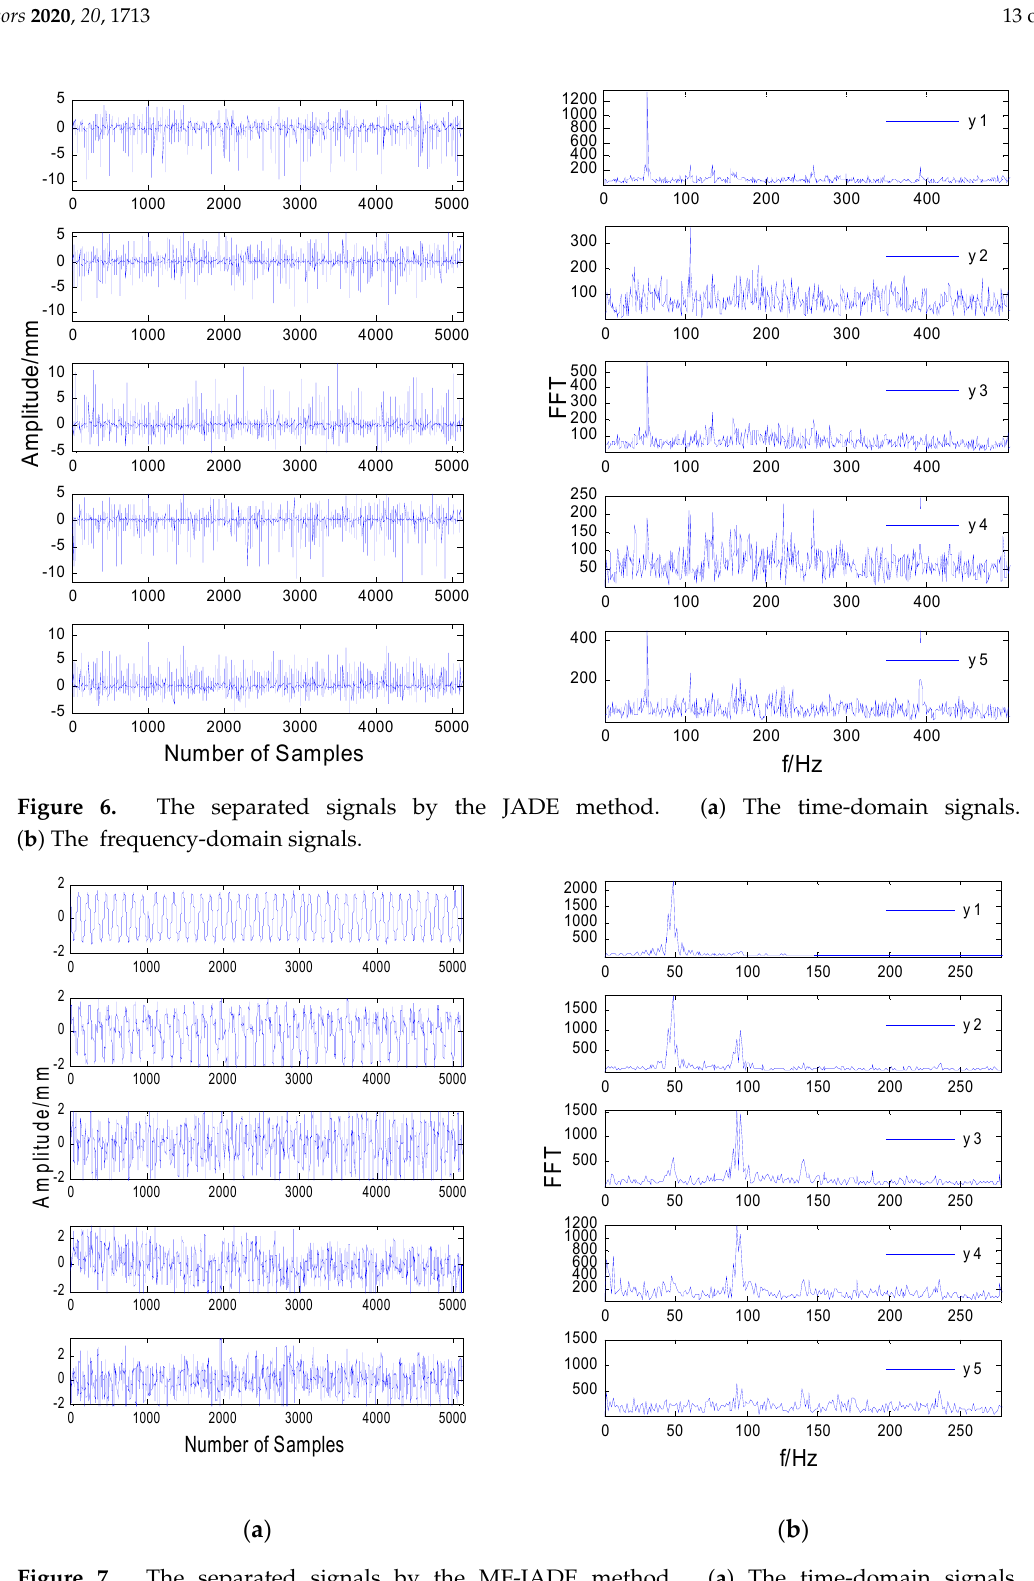
Figure 7. The separated signals by the MF-JADE method. ( a ) The time-domain signals. ( b ) The frequency-domain signal.